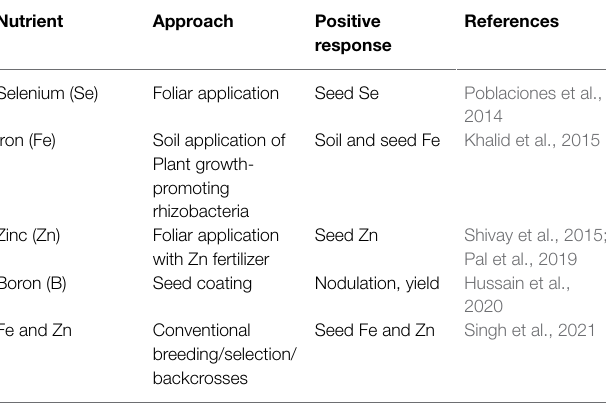
TABLE 2 | Biofortification methods for